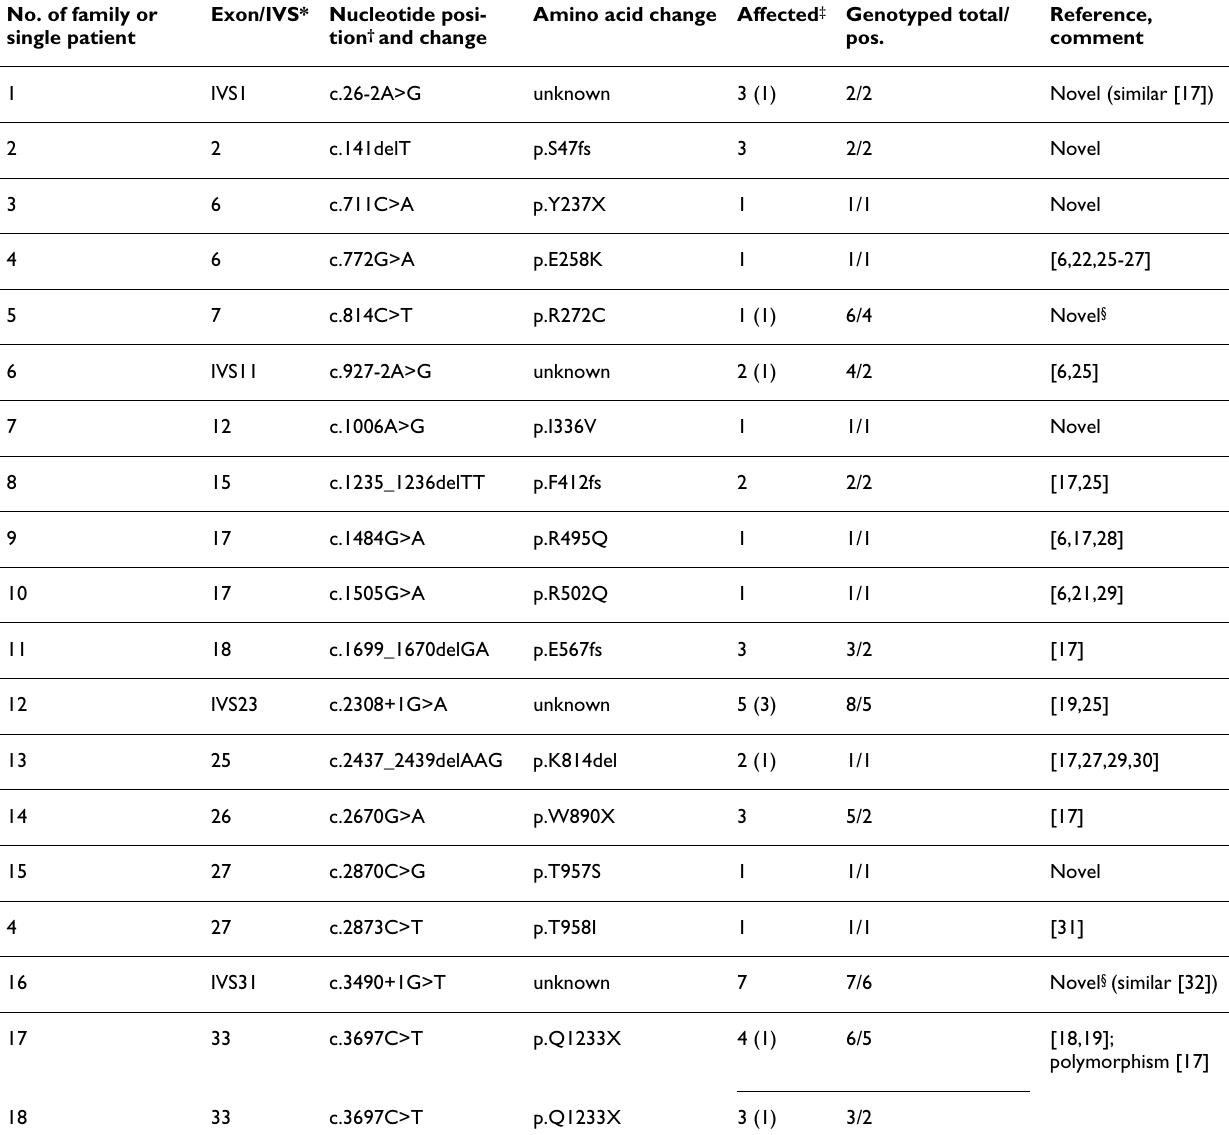
Table 1: MYBPC3 mutations detected in this study Amino acid change Affected ‡ Genotyped total/ No. of family or Exon/IVS* Nucleotide posi- single patient tion † and change